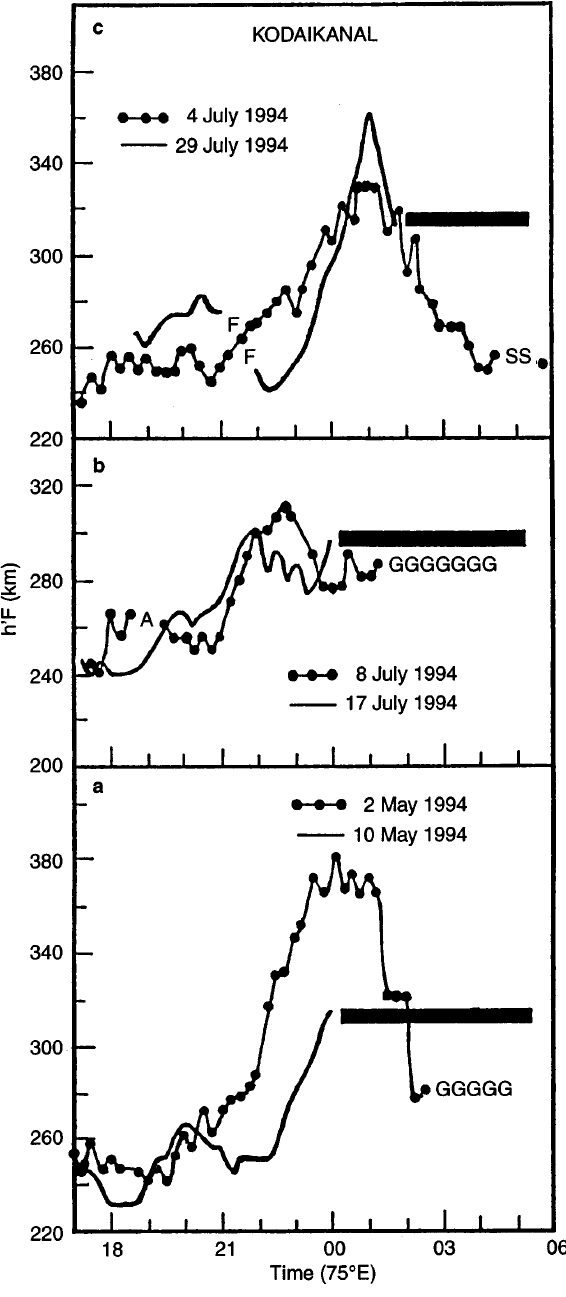
Fig. 1. Examples of the local time variation of h 0 F at Kodaikanal on nights with post-midnight onset of spread-F ( solid curves ) and without spread-F ( curves with filled circles ). The solid rectangles represent the duration of spread-F. The qualifying letters G and S indicate no-echo and interference